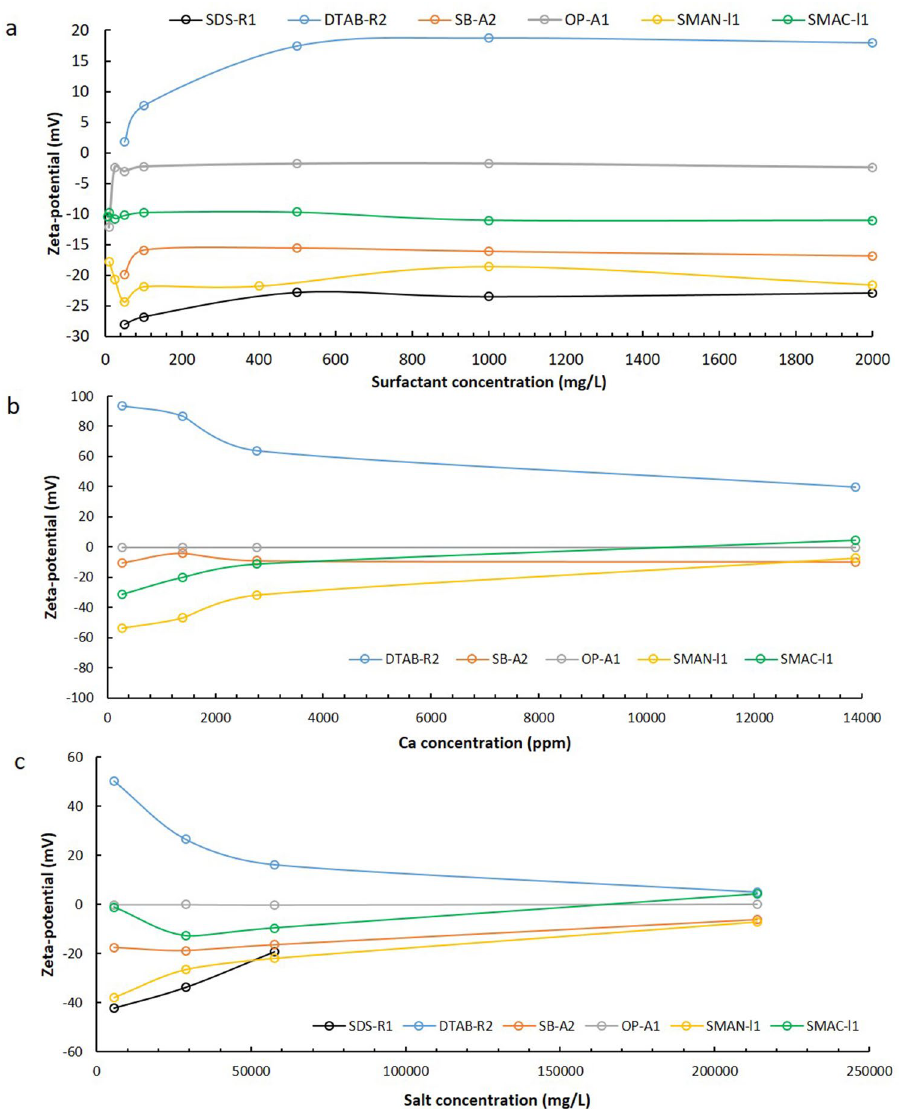
Figure 2. The zeta-potentials of oil droplets ( a ) in different concentrations of surfactants in HSW, ( b ) in 2000mg/L surfactants in different concentrations of calcium and ( c ) in 2000 mg/L surfactants in diluted HSW, HSW and connate water. Black line SDS-R1, blue line DTAB-R2, orange line SB-A2, gray line OP-A1, yellow line SMAN-l1, green line